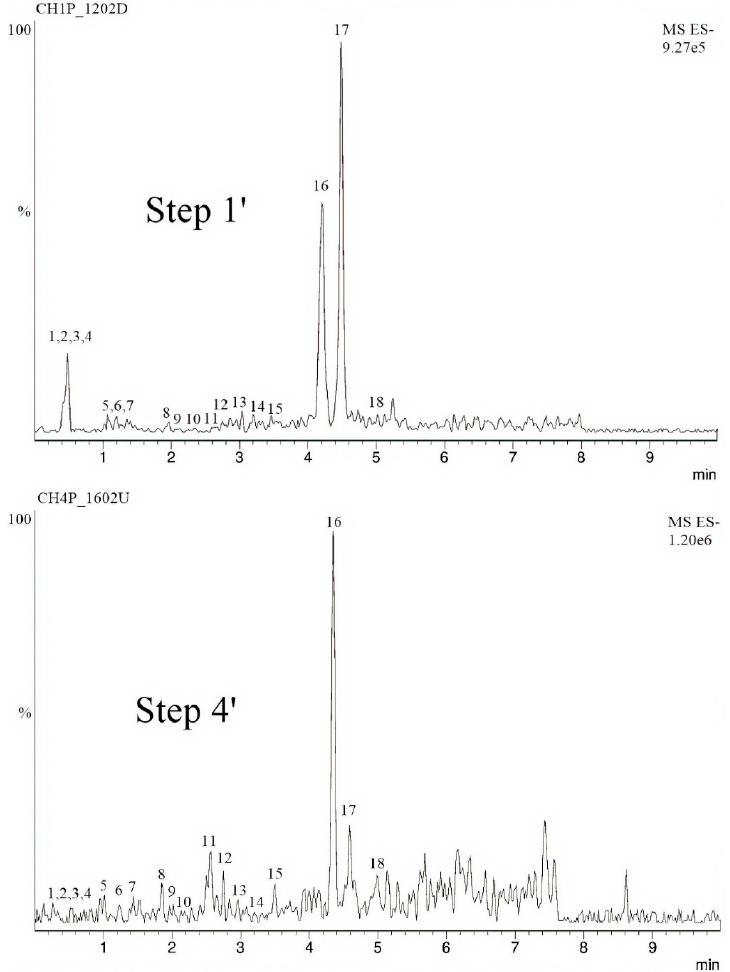
Figure 12. Base peak chromatograms comparing steps 1 ′ and 4 ′ of the seedling leaf explants from Clidemia hirta. Table 3. Survey of the detection of the selected compound markers when the starting material is leaves from axenic plantlets.